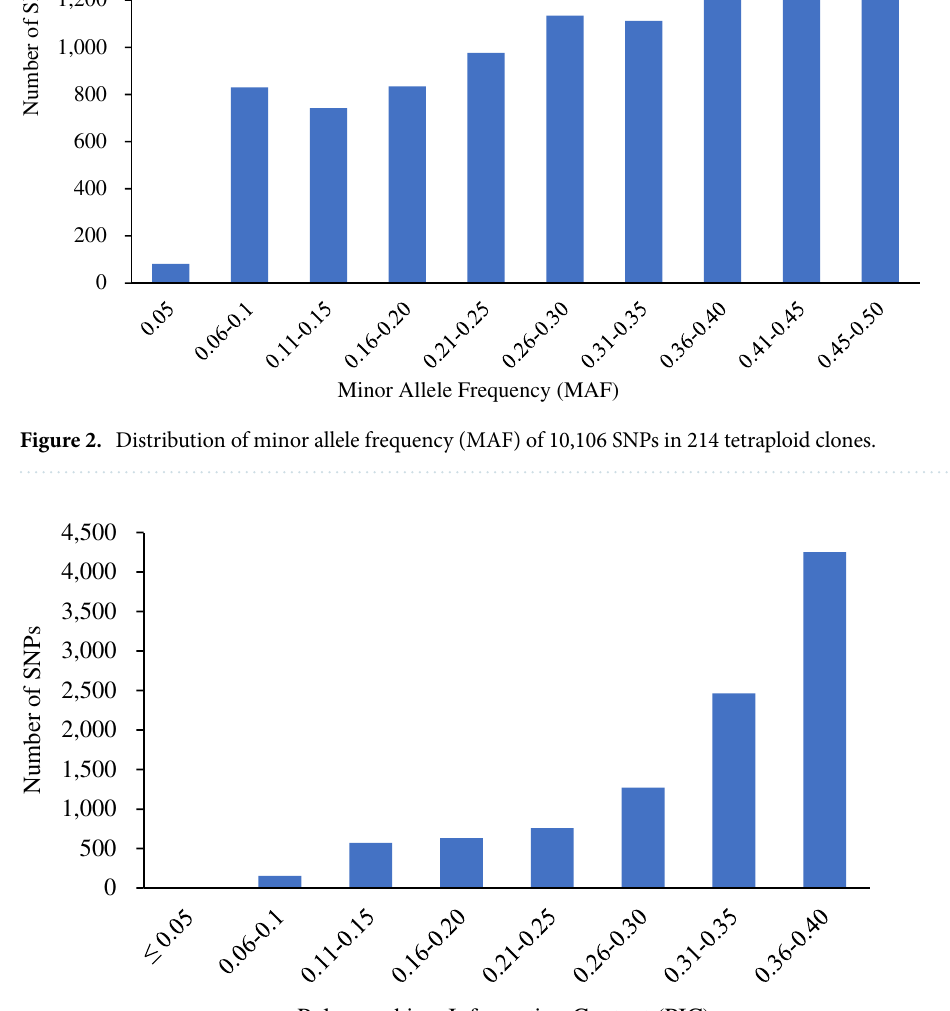
tah and its strain selections (8.4% of total clones) were grouped in a separate subpopulation 2 (Green) (Fig. 4, Supplementary Information Table S5). The majority of russet and chipping clones (40.6% of total clones) were grouped to subpopulation 3 (Blue) (Fig. 4; Supplementary Information Table S5). For instance, the chipping clone Atlantic and the russet clone Reveille Russet had complete membership to subpopulation 3. STRU CTU RE analysis revealed significant admixtures in 4.67% of the total clones. e.g., White LaSoda, TX11454-9Ru/Y, and COTX87601-2Ru (Fig. 4; Supplementary Fig. S2; Supplementary Information Table S5). Discriminant analysis of principal components (DAPC) analysis. The lowest Bayesian information criterion (BIC) value obtained using find.clusters function was three (Supplementary Fig. S3), which was in concordance with the delta K obtained in STRU CTU RE. These three clusters were used to analyze the DAPC (Fig. 5). Twenty principal components capturing 34.3% variance and two discriminant eigenvalues were retained. These values were confirmed by a cross-validation analysis (Supplementary Fig. S4). Genotypes had member- ship coefficients to each group ranging from 0.5 to 1, thus confirming low admixture and structured population (Supplementary Information Table S6). Exceptions to these values were clone NDTX059775-1 W (chipper with white flesh), COTX10118-4Wpe/Y (specialty with white skin purple eyes, and yellow flesh), COTX03079-1 W (chipper with white flesh), and COTX94216-1R (red skin white flesh) whose values were 0.36, 0.40, 0.43 and 0.44 respectively. In Fig. 5, Linear Discriminant 1 (LD 1) separated Russet Norkotah and Red groups from Chip